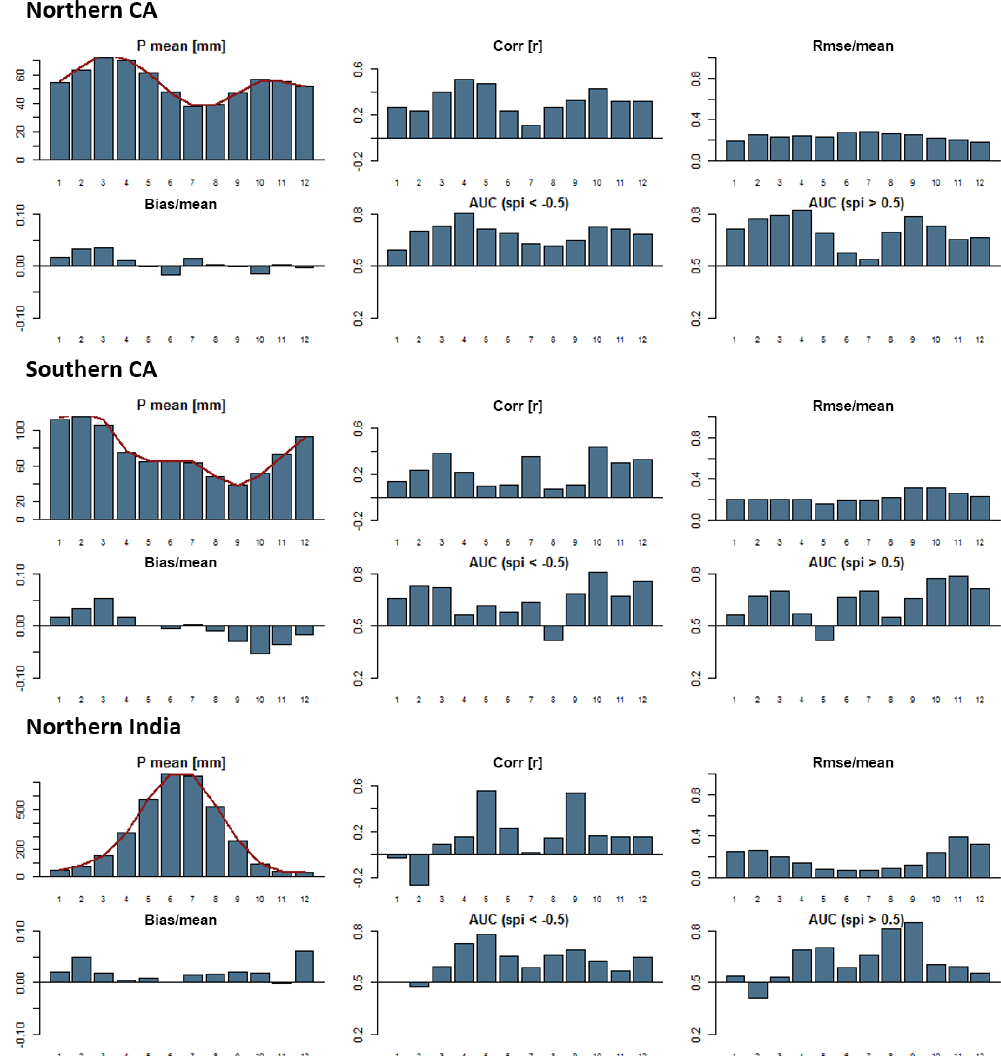
Figure 7. Summary of evaluation measures of the F [1:3] forecast for selected target areas. In order to keep the annual cycle of precipitation amounts, the specified month at the x axis indicates the middle of the forecast